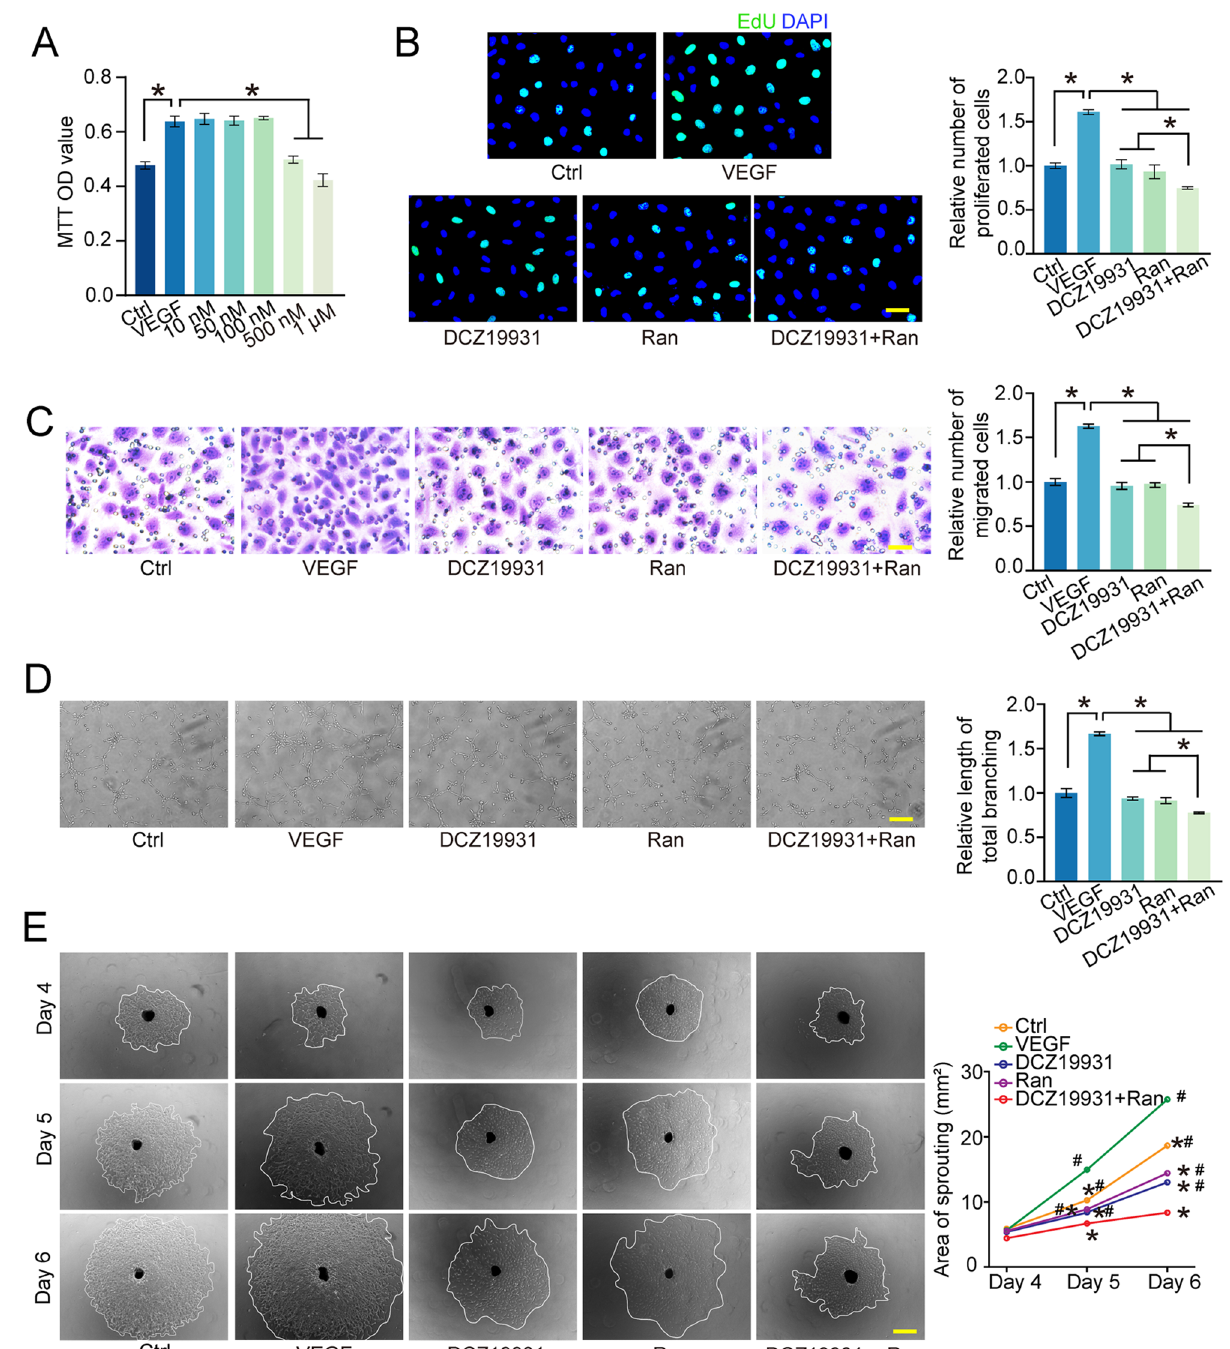
Figure 4. DCZ19931 exhibits anti-angiogenic effects in vitro. ( A ) HUVECs were pre-treated with VEGF (10 ng/mL) for 12 h and then treated with DCZ19931 at the concentration of 10 nM to 1 μM for 24 h. Cell viability was determined by MTT assay (n = 4). ( B – D ) HUVECs were pre-treated with VEGF (10 ng/mL) for 12 h and then treated with DCZ19931 (500 nM), Ranibizumab (250 μg/mL), DCZ19931 (500 nM) plus Ranibizumab (250 μg/mL), or left untreated (VEGF) for 24 h. The group without VEGF treatment was taken as Ctrl group. Cell proliferation was detected by EdU assays ( B , n = 4, scale bar, 20 μm). The cells were allowed to migrate for 12 h at 37 °C and 5% CO 2 and cell migration ability was assessed by transwell assays ( C , n = 4, scale bar, 20 μm). HUVECs were seeded on matrigel matrix and cultured. Tube formation ability was observed under a light microscope at 8 h after seeding ( D , n = 4, scale bar, 100 μm). ( E ) The mouse choroidal sprouting assays were conducted to measure the angiogenic potency of choroidal explants at day 4, day 5, and day 6 after culture. Representative images of the choroidal sprouting areas at indicated time points were shown (n = 4, scale bar, 200 µm). Statistical significance was evaluated by one-way ANOVA followed by Bonferroni post hoc test. For ( A – D ): * P < 0.05 indicated significant difference between the marked groups. For ( E ): * P < 0.05 vs. VEGF group, # P < 0.05 vs. DCZ19931 + Ranibizumab